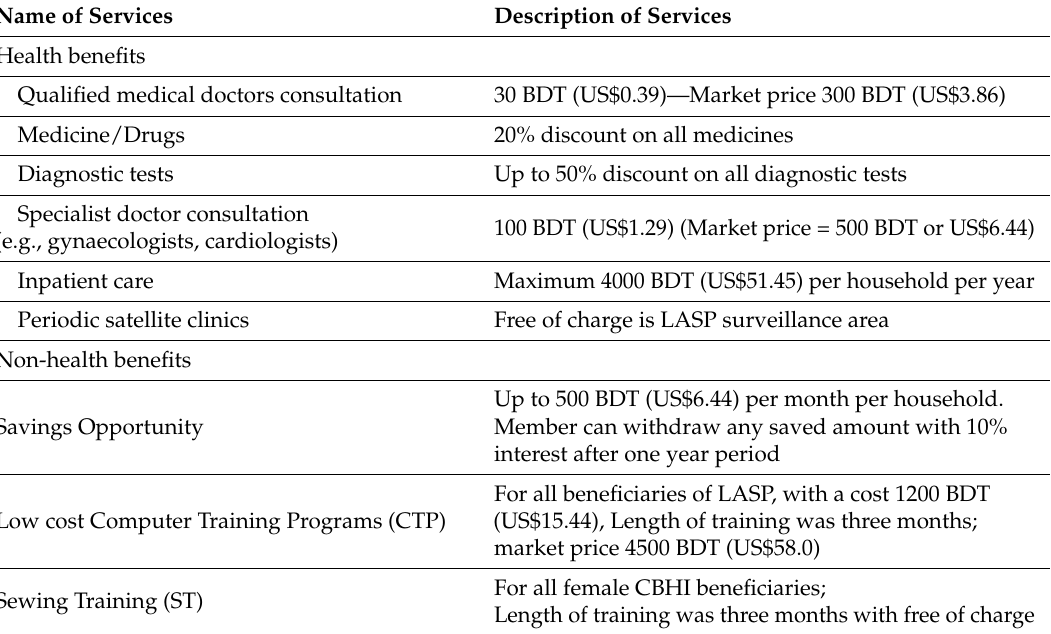
Table 1. The benefits package of the